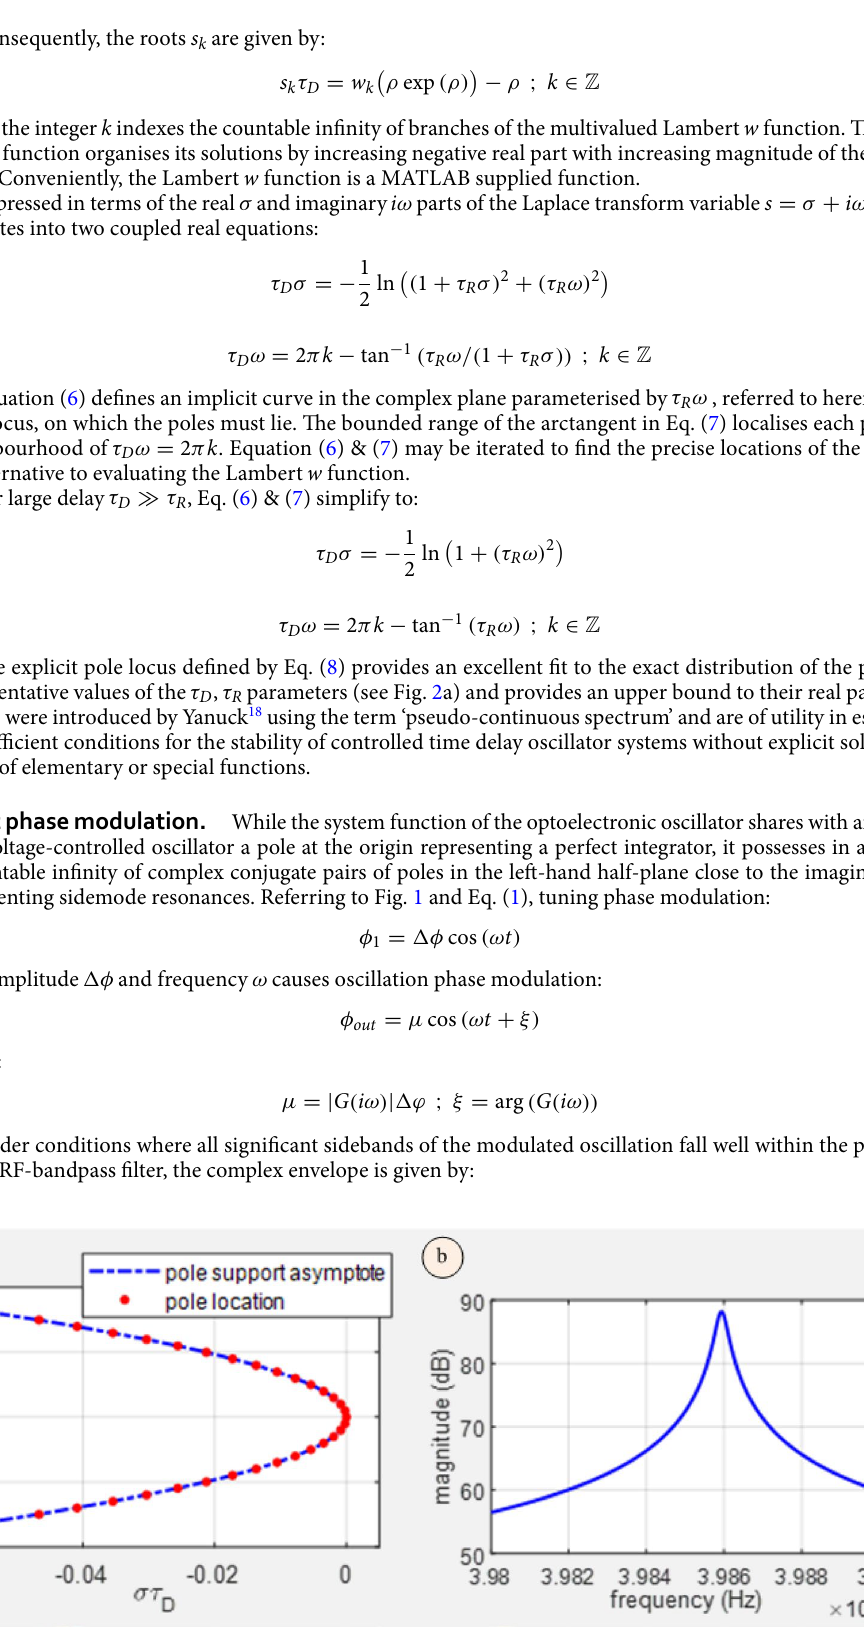
Figure 2. ( a ) A comparison of the poles of the system function of a free time delay oscillator and the asymptotic curve defined by Eq. (8); ( b ) Bode plot of the transfer function of an optoelectronic voltage-controlled oscillator relative to an orthodox voltage-controlled oscillator with equivalent static tuning sensitivity-in a neighborhood of the first sidemode